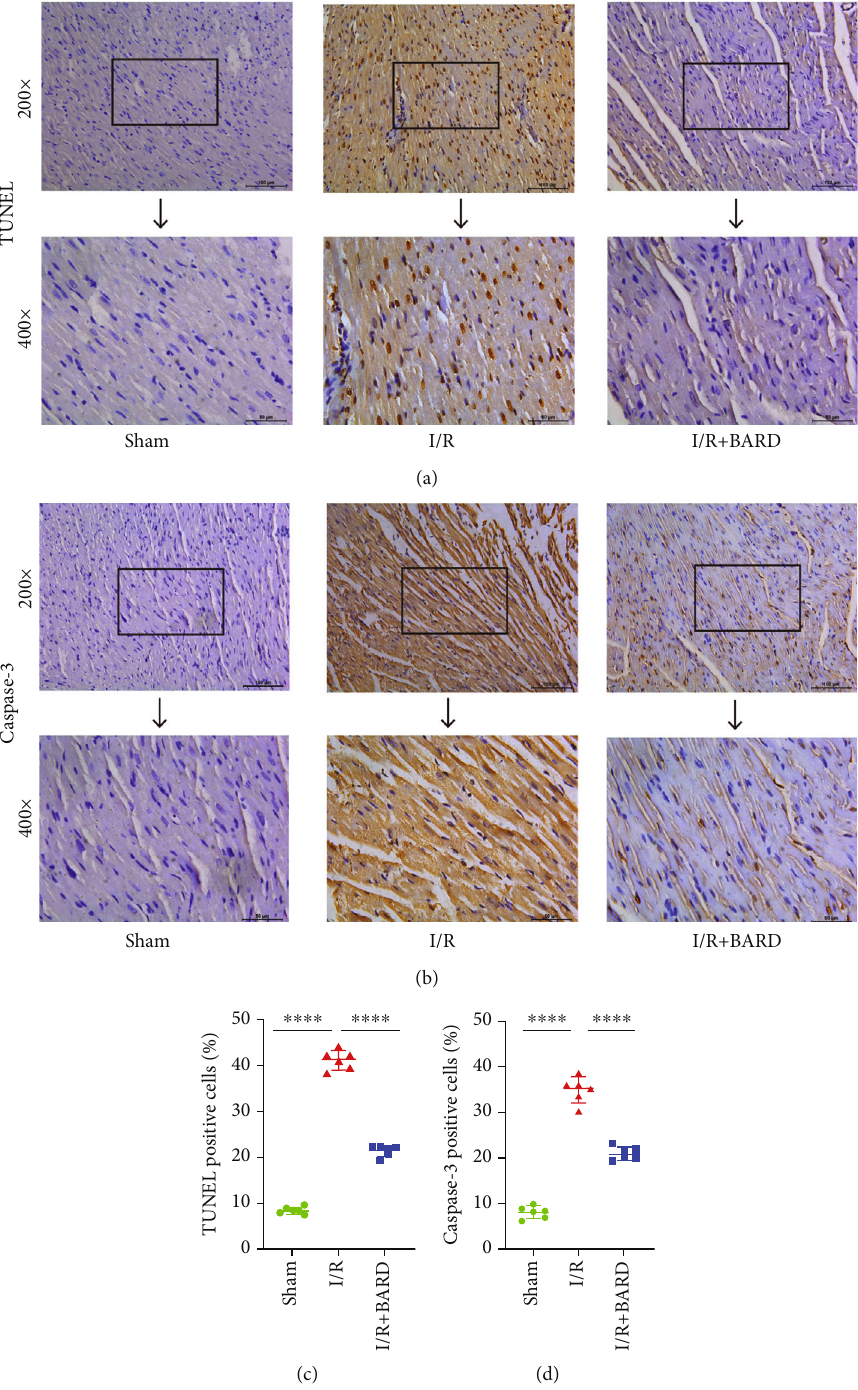
Figure 3: BARD alleviates cardiomyocyte apoptosis caused by myocardial I/R. (a) TUNEL staining. (b) Caspase-3 immunohistochemistry staining. (c) The positive cell amount of TUNEL ( n = 6 ). (d) The amounts of caspase-3-positive cells ( n = 6 ). Magni fi cation of microscope: × 200 and × 400. Scale bar: 50 μ m and 100 μ m. ∗∗∗∗ P < 0 : 0001